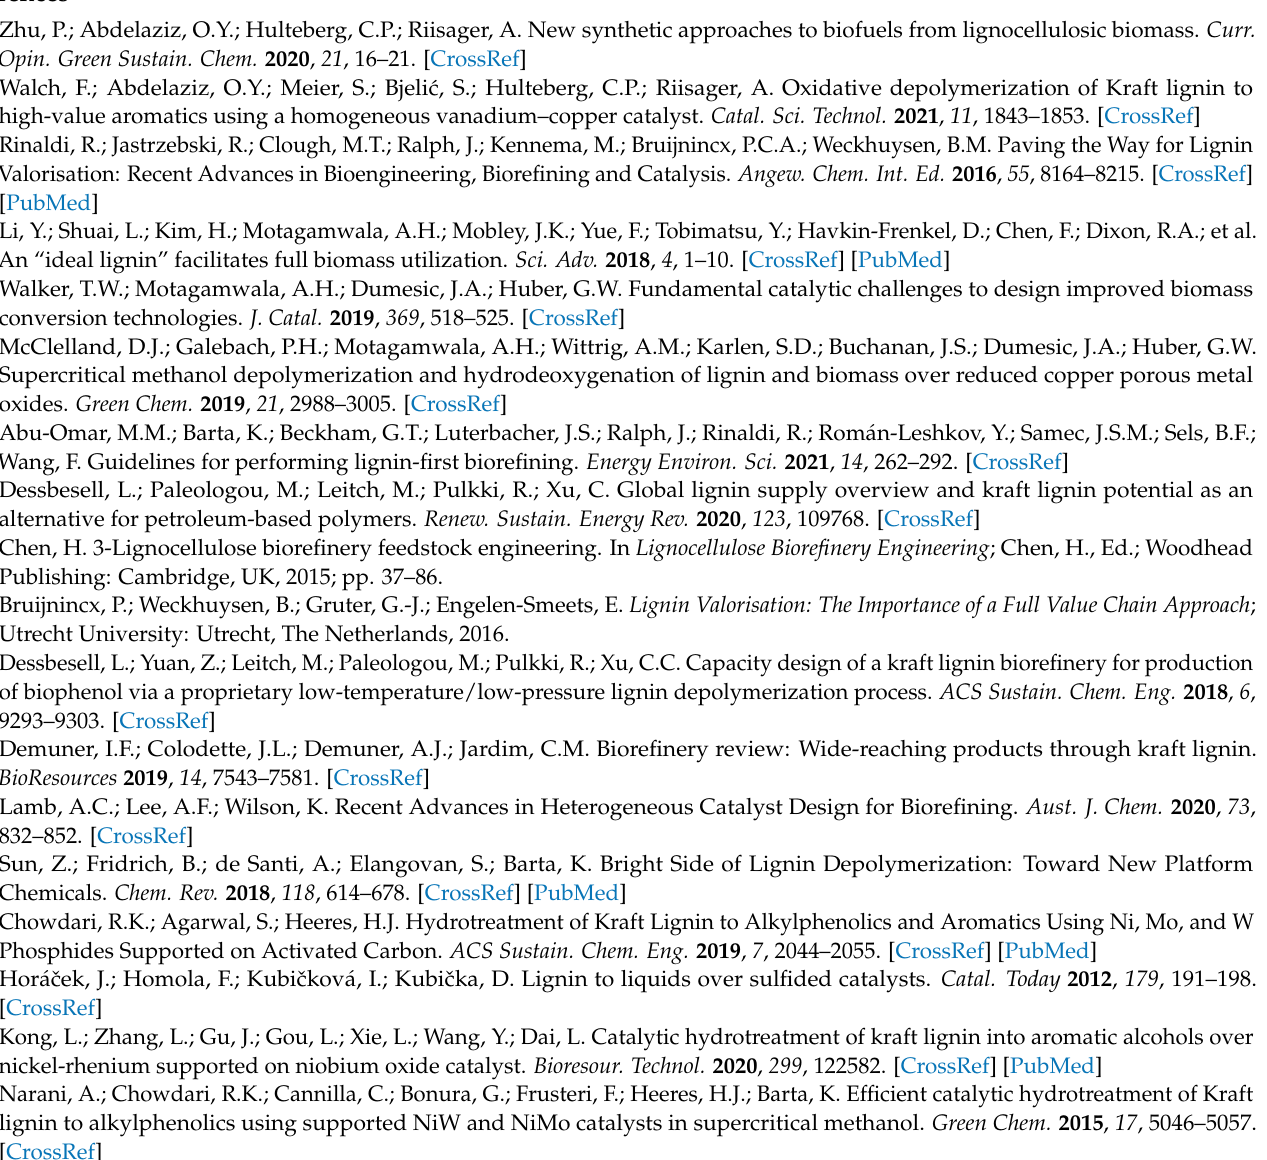
Figure S2: TGA/DSC analysis of kraft lignin; Figure S3: Products identification of reaction product obtained over NiMoS/Al 2 O 3 ; Figure S4: Chromatogram of the reaction product obtained after the 3rd run of catalyst; Figure S5: Chromatogram of the reaction product obtained over 2.5wt%Na– NiMoS/Al 2 O 3 ; Figure S6: 1 H NMR spectra of the kraft lignin and pretreated kraft lignin in DMSO-d 6 ; Figure S7: 2D HSQC NMR spectra of (A) and (B) kraft lignin, and (C) and (D) pretreated kraft